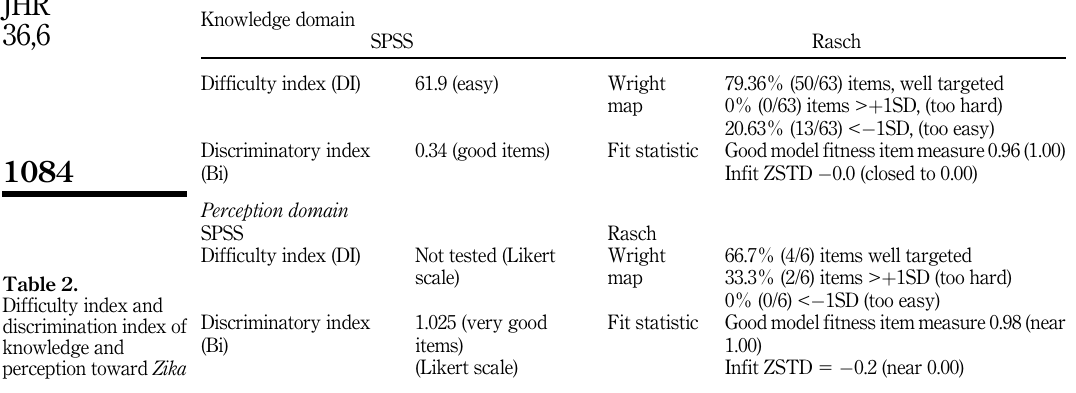
Table 2. Difficulty index